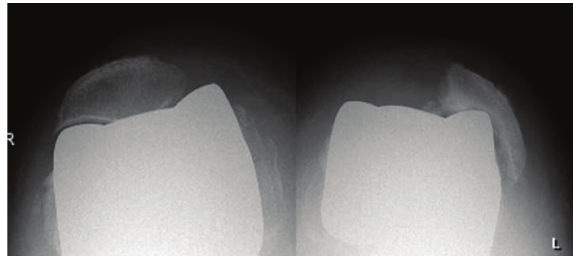
Figure 2: Bilateral image showing a patellofemoral deformity with obvious patellar luxation at the left